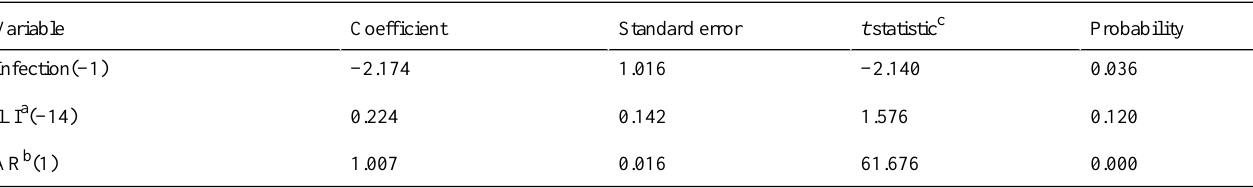
Table 4. Results of model